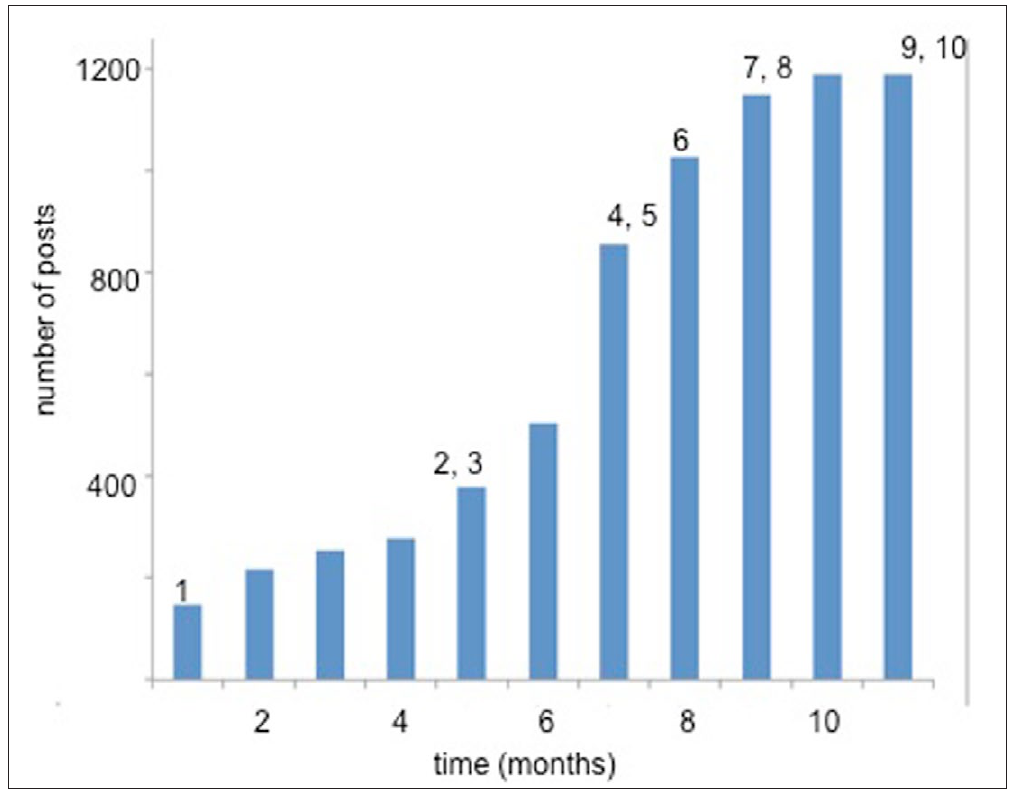
Figure 2: Timeline of GPAC thread: The numbers on the graph indicate the events identified in Table 2 .